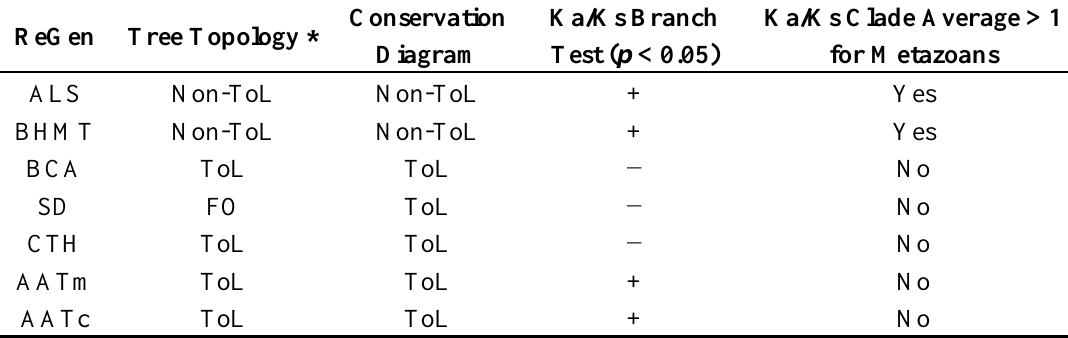
Table 5. Summary of